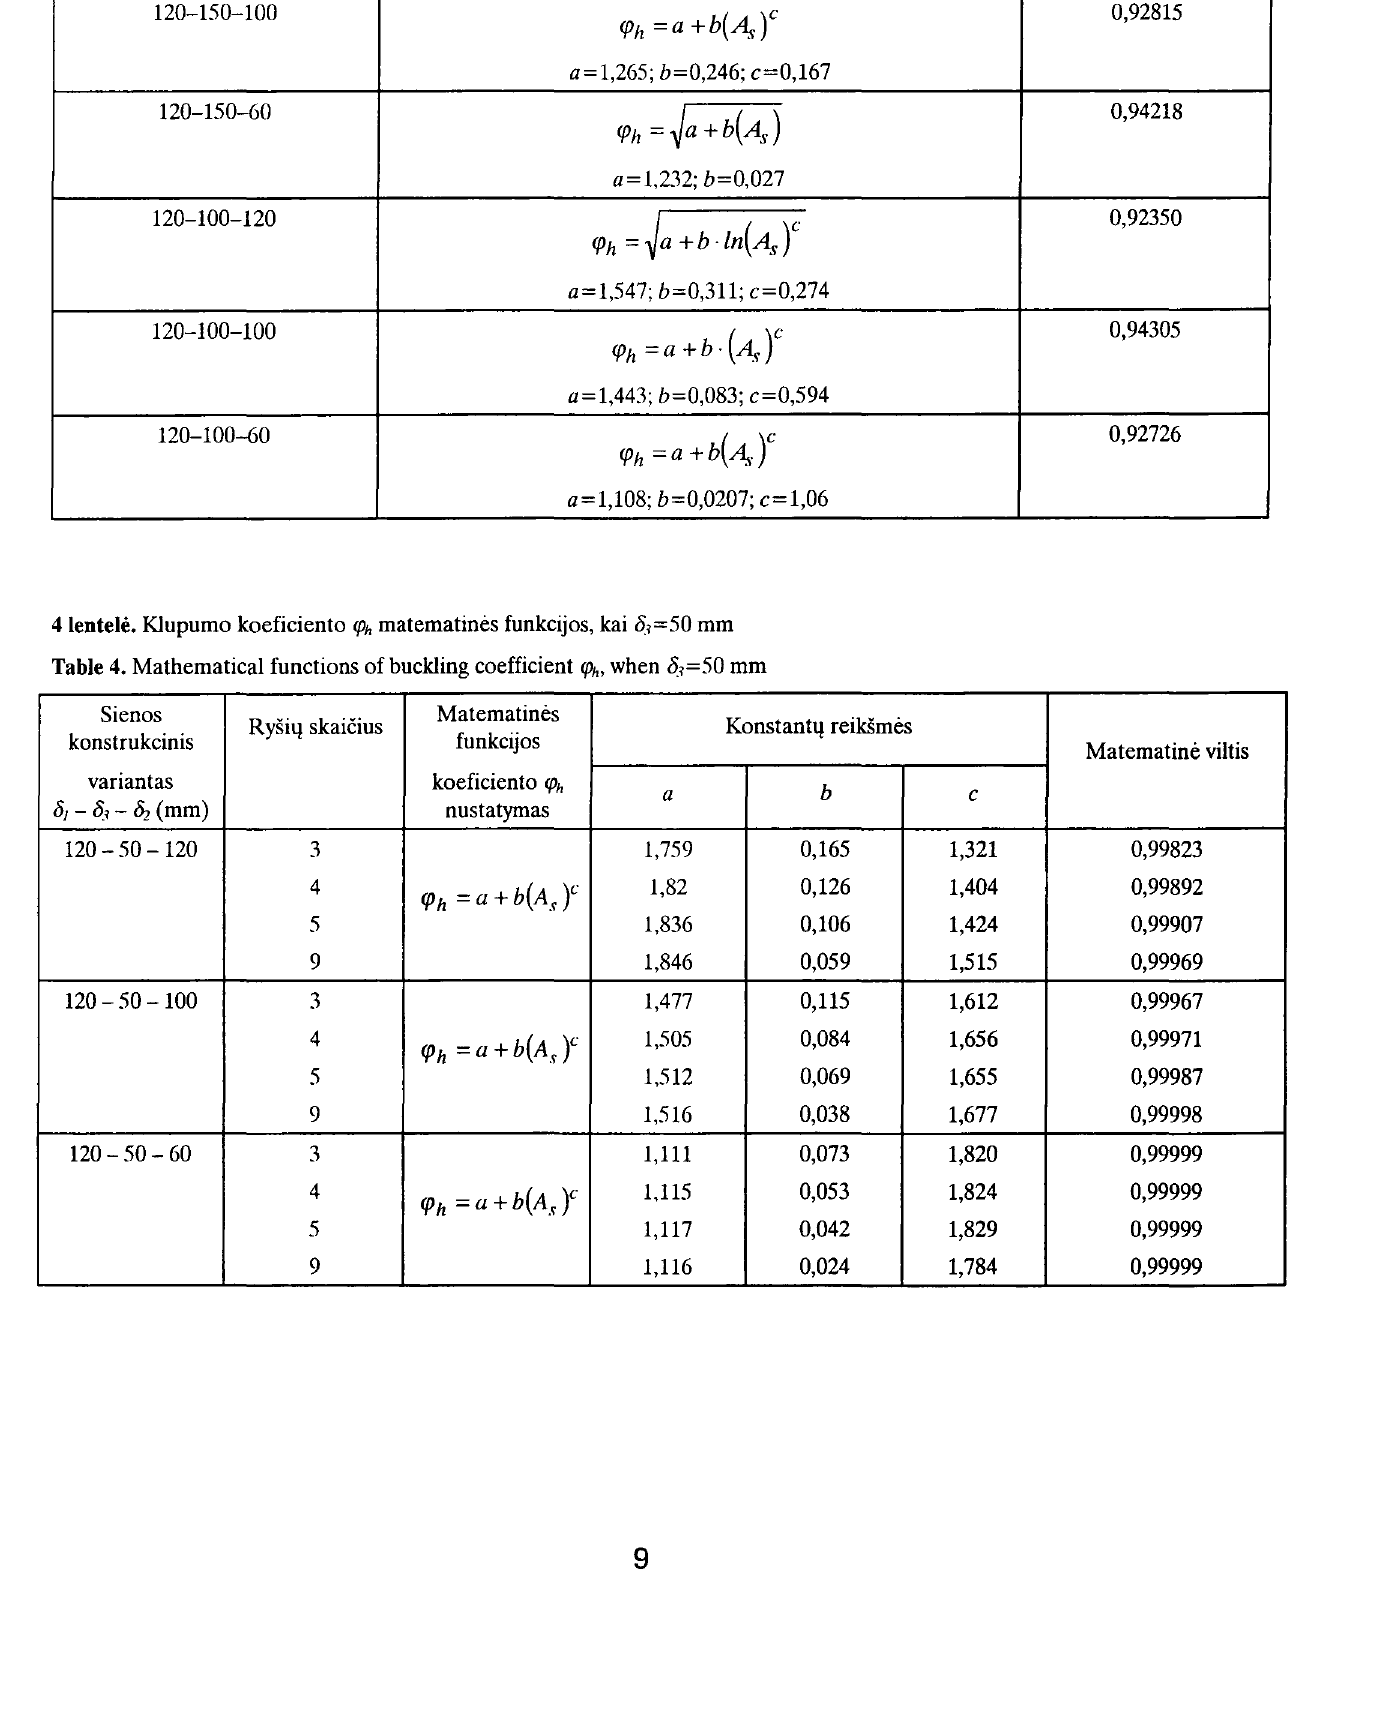
Table 3. Mathematical functions of buckling coefficient (/Jh, when 8_ 1= 150 and 100 mm Sienos konstrukcinis variantas